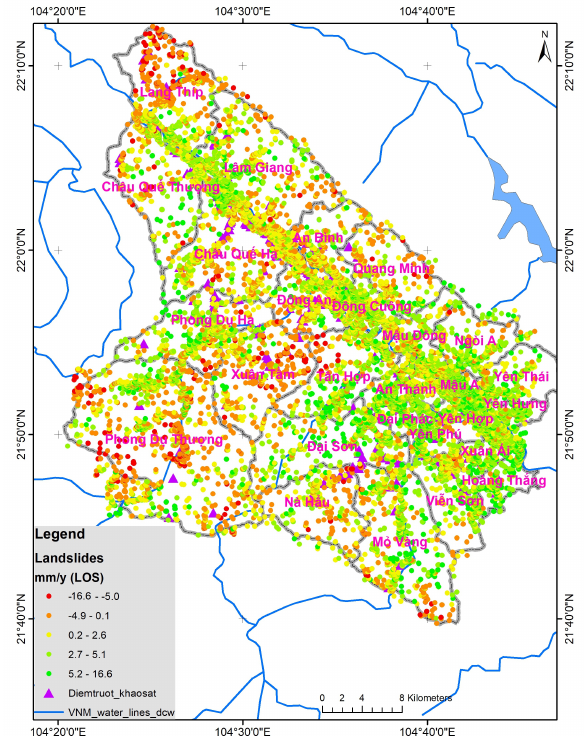
Figure 5. Landslides in Van Yen, Yenbai Province; the violet triangle are the landslides survey points (Quoc Hung et al.,